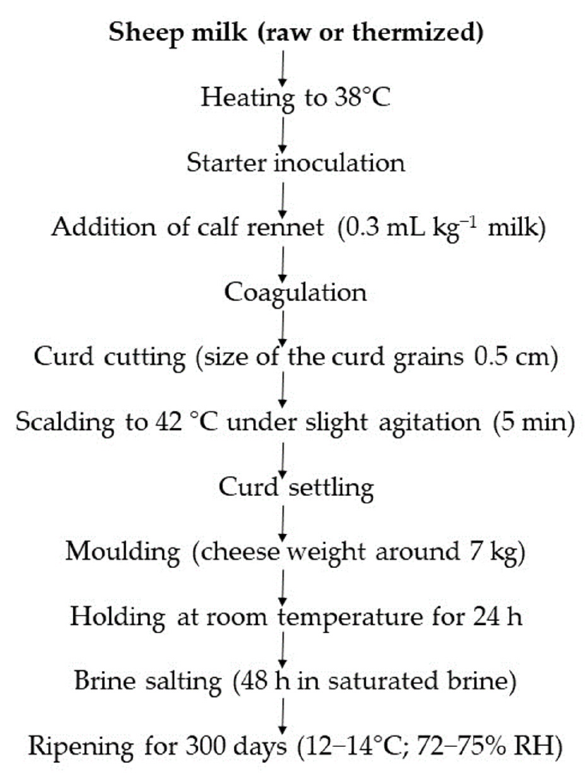
Figure 2. Cheesemaking process applied in the